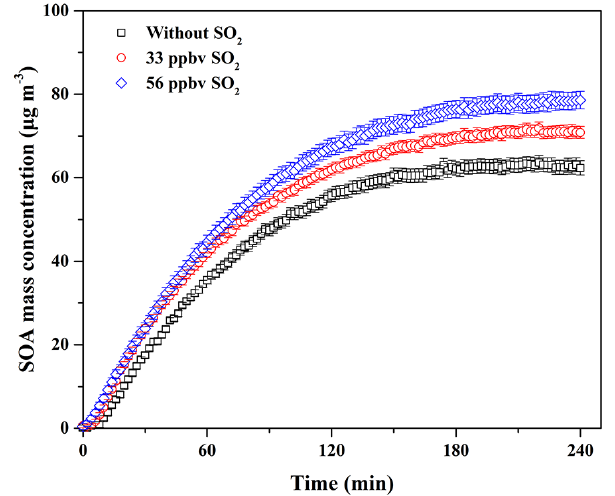
Figure 3. Variations in the τ g − p /τ g − w ratio in the presence of var- ious seed particles as a function of SO 2